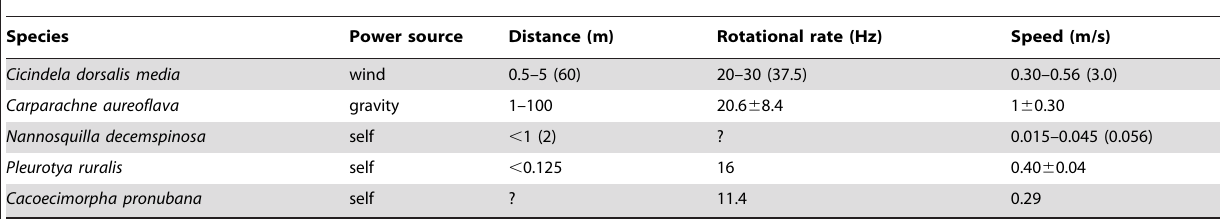
Table 5. Wheel locomotion performance across